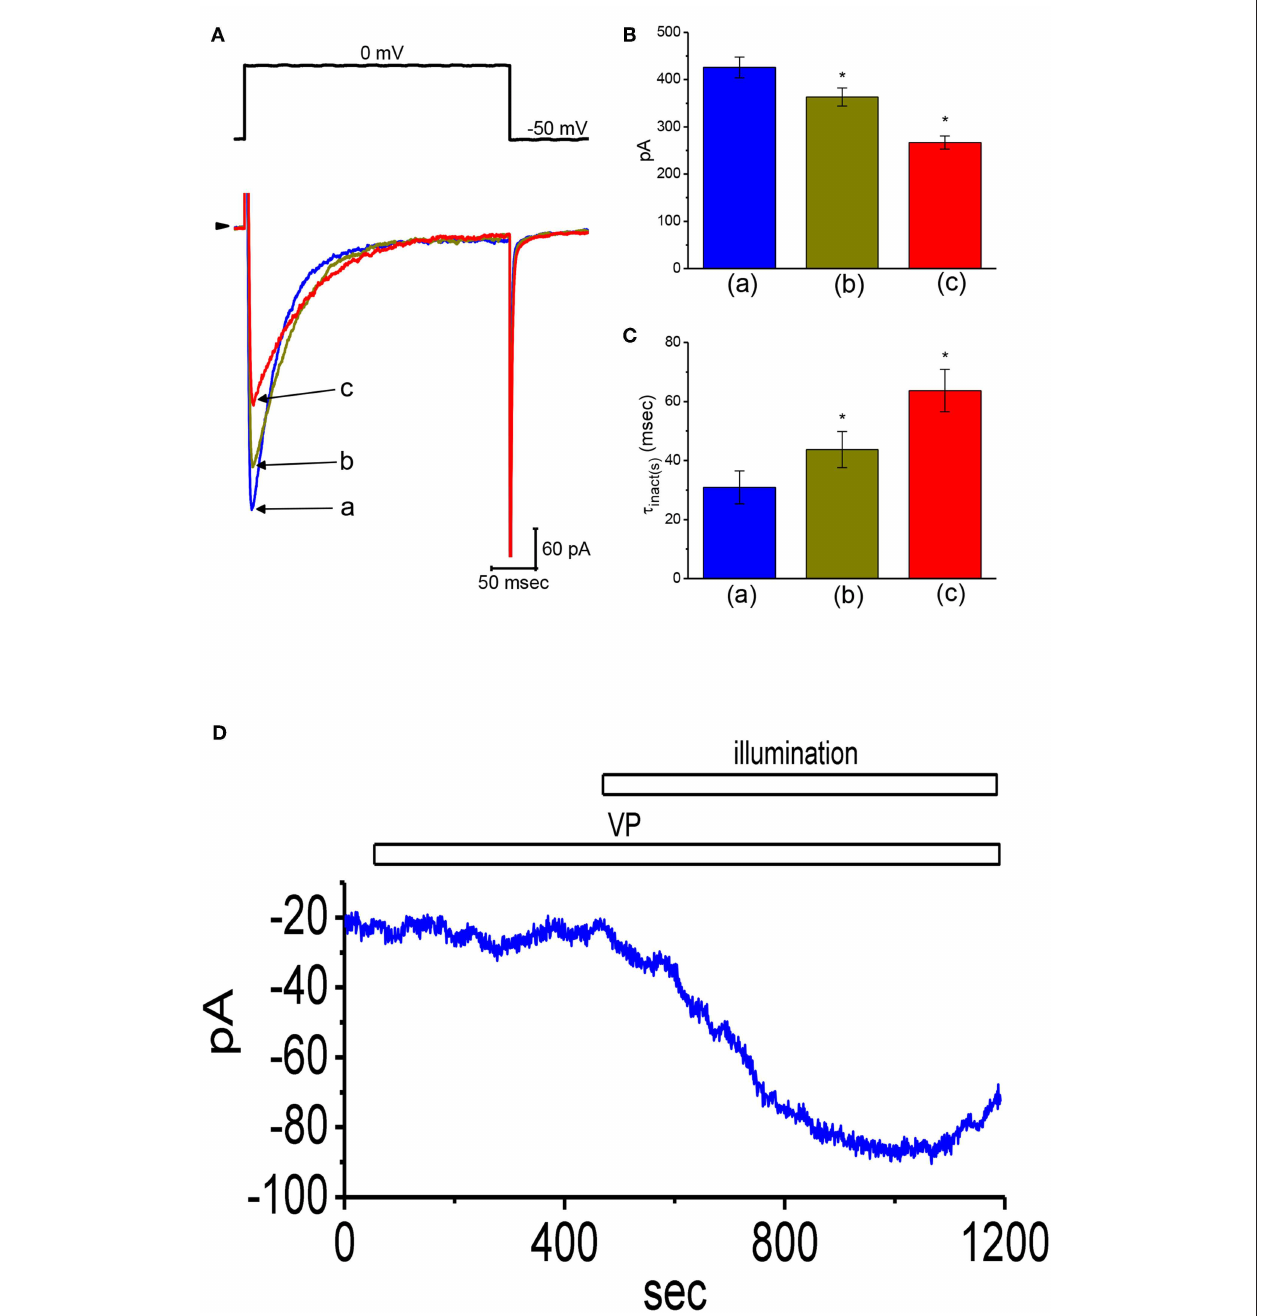
FIGURE 7 | Effects of VP on L-type Ca 2 + current ( I Ca,L ) and non-selective cation current ( I NS ) in GH 3 cells. In this set of experiments, we bathed cells in normal Tyrode’s solution containing 1.8mM CaCl 2 , 1 µ M TTX, and 10mM TEA, and the pipette used was filled with Cs + -containing solution. (A) Original I Ca,L traces elicited by membrane depolarization from − 50 to 0mV [indicated in the upper part of (A) ]. a: control; b: 1 µ M VP; c: 3 µ M VP. Panels (B) and (C) depict summarized bar graphs showing the effect of VP on the peak amplitude of I Ca,L and the slow component of inactivation time constant ( τ inact(s) ) for I Ca,L , respectively (mean ± SEM; n = 12 for each bar). (D) Change in the amplitude of I NS obtained in the presence of VP and VP plus illumination. The examined cell was held at the level of − 50mV. The horizontal bar indicates addition of 3 µ M VP or illumination with light intensity of 5.5 mW/cm 2 . *Significantly different from control ( P < 0.01).